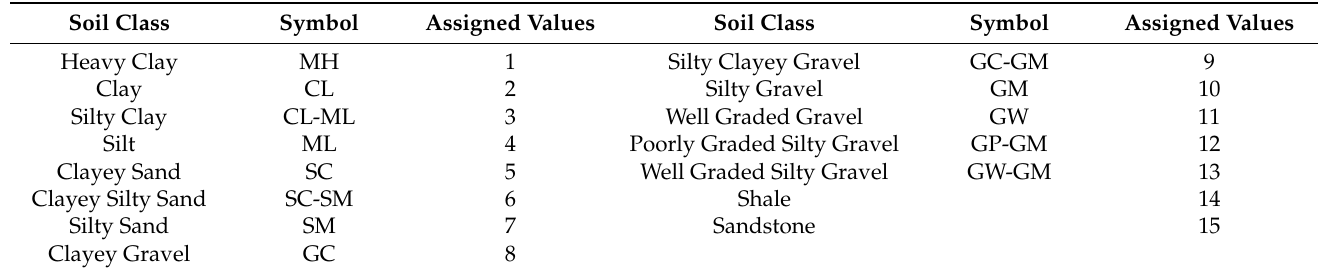
Table 1. Soil sample classes and assigned values to be used in the GIS